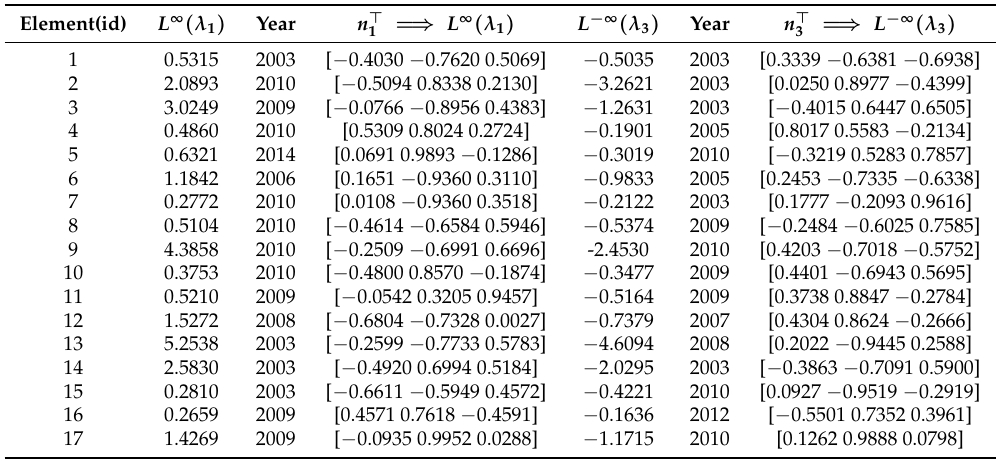
Table 4. Maximum and minimum eigenspace components in the time